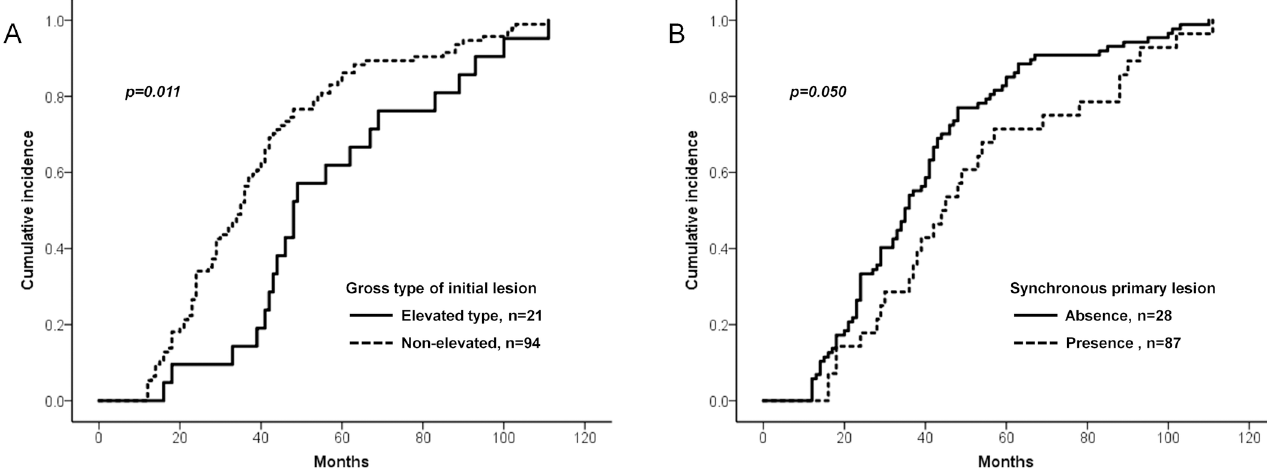
Fig 3. Factors associated with early occurrence of MGT after ESD. (A) Cumulativeincidenceof MGT by gross type. (B) Cumulative incidenceof MGT by presence of synchronous primary lesions.